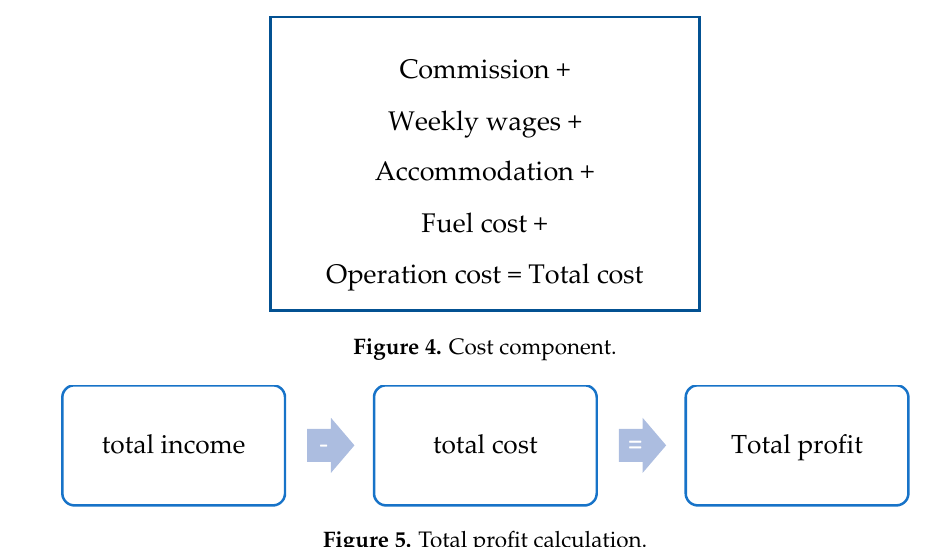
Figure 5. Total profit calculation.